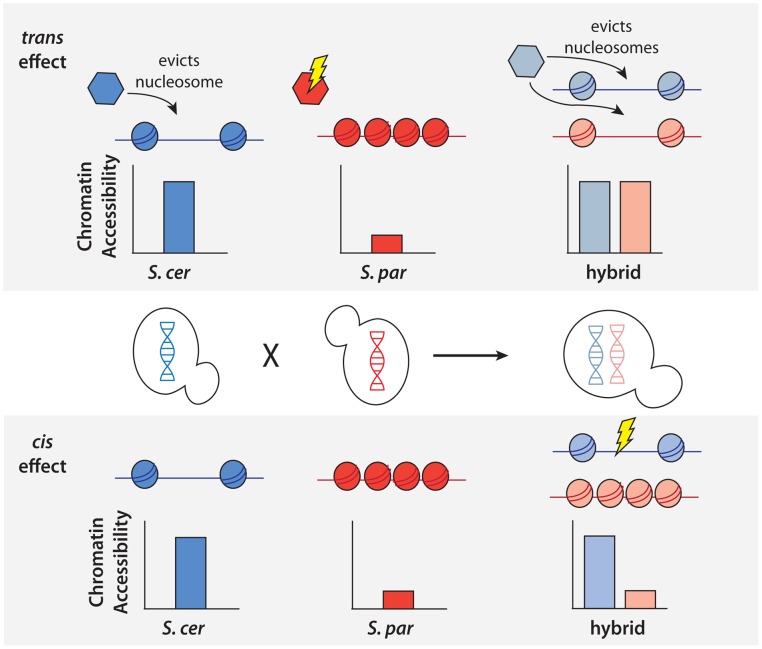
Schematic of approach to detect cis and trans effects on chromatin accessibility.Top, an example of a NFR showing only a trans effect on chromatin accessibility. A trans effect is detected as a case where there is a difference in chromatin accessibility between the two parental haploid species, but there is no difference in chromatin accessibility between the two alleles in the hybrid. As shown above, this could be explained by a case where a nucleosome remodeler (shown as a hexagon) acts to evict nucleosomes and increase accessibility in S. cerevisiae, but a mutation in S. paradoxus has rendered it inactive and it is unable to evict the nucleosomes. In the diploid hybrid, the chromatin remodeler from S. cerevisiae is able to evict nucleosomes from both the S. cerevisiae and S. paradoxus chromosomes. Bottom, an example of a NFR showing only a cis effect on chromatin accessibility. A cis effect is detected as a difference between the accessibility detected between the two alleles in the diploid, and the lack of a trans effect is shown by the same difference being detected between the parental species. In this case, there has been a mutation at the NFR on the S. cerevisiae allele, leading to a difference in the number of nucleosomes binding in the region.